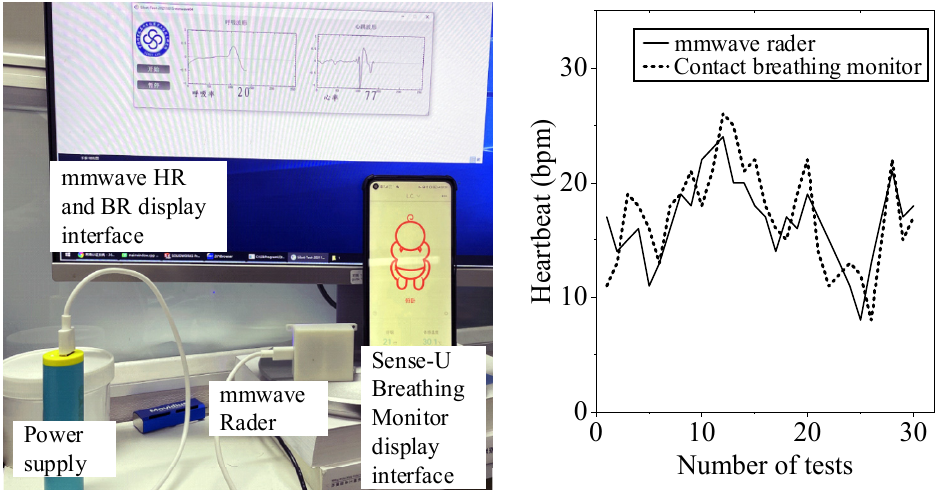
Figure 21. Comparative experiment with contact breathing monitor.